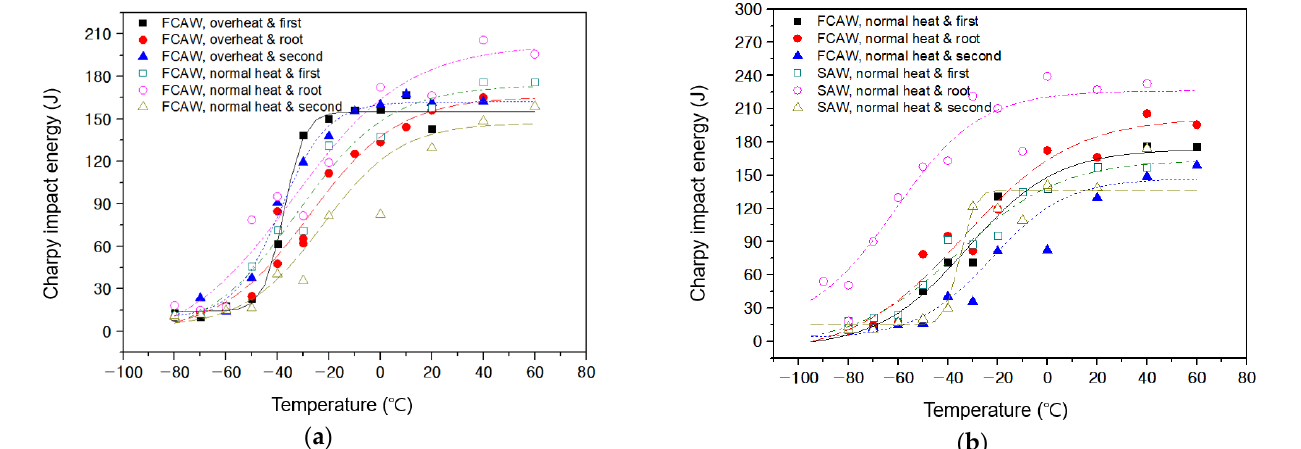
Figure 6. Charpy impact test results: ( a ) Charpy transition curve according to heat input; ( b ) Charpy transition curve according to welding method. Table 4. Hyperbolic tangent curve fit coefficient of impact test results according to sample location.